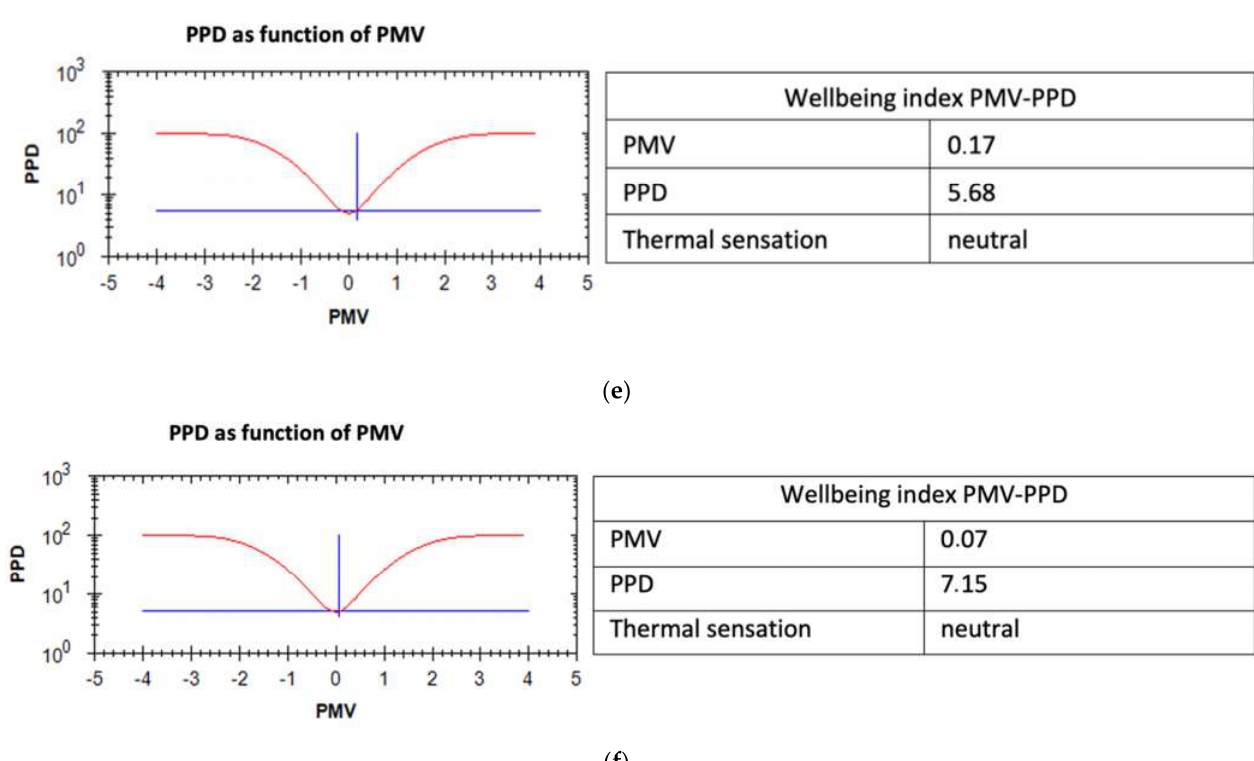
Figure 1. PMV (presumed mean value) and PPD (presumed percentage of dissatisfied) as detected on: ( a ) 24.09.2016; ( b ) 29.09.2016; ( c ) 30.09.2016; ( d ) 06.10.2016; ( e ) 06.12.2016; ( f ) 07.12.2016.